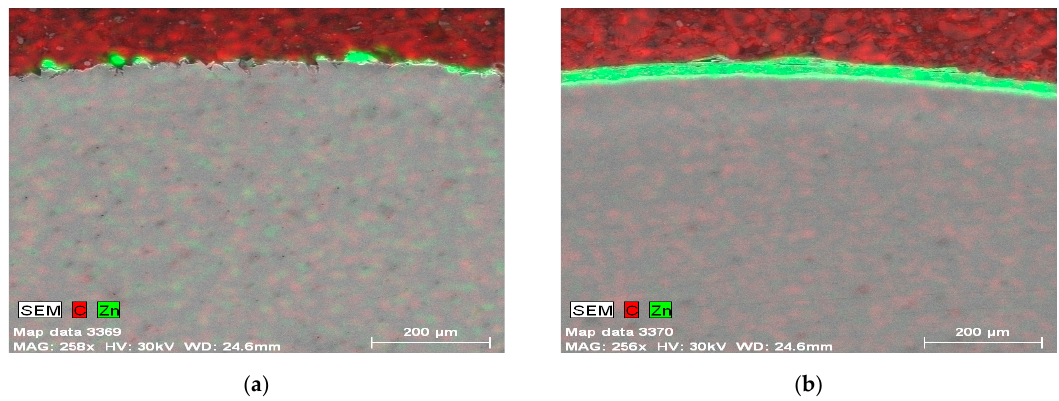
Figure 8. Chemical maps of galvanized wire: ( a ) position 1, ( b ) position 4.